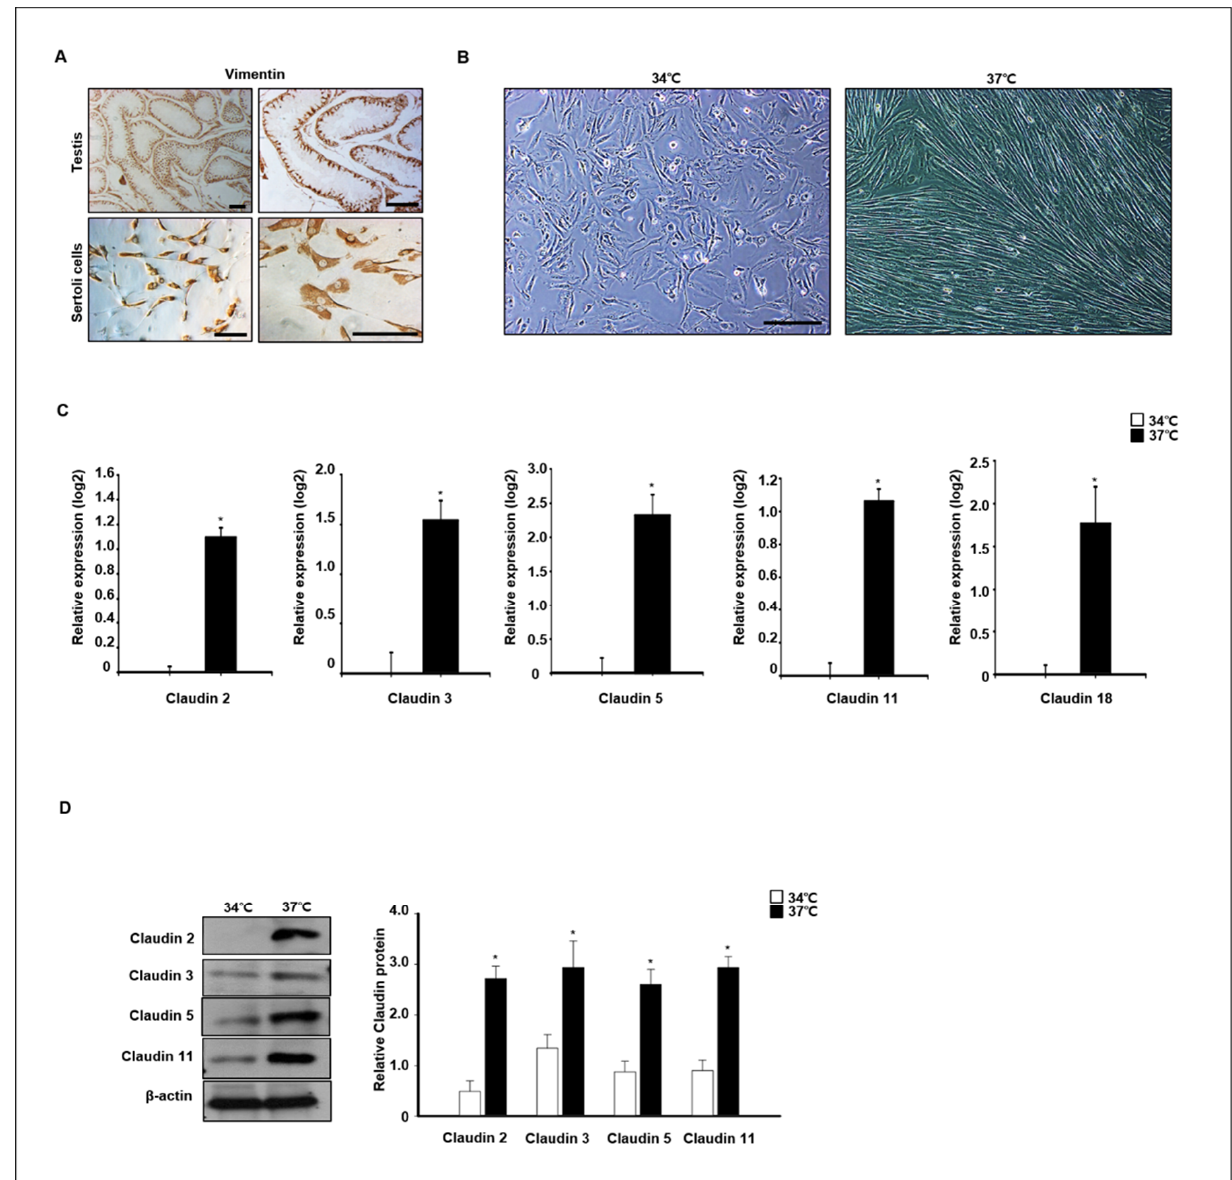
Figure 8. Effect of temperature on claudin expression in in vitro-cultured canine primary Sertoli cells. ( A ) Primary canine Sertoli cells were isolated from 12-month old dog testes. Isolated cells and whole testes were stained with vimentin antibodies as a Sertoli cell marker. ( B ) Images of the morphological change in primary Sertoli cells were taken from cells cultured at 34 and 37 ◦ C. Scale bars = 50 µ m. ( C ) The expression of claudins 2, 3, 5, 11, 18 was determined by qPCR from Sertoli cells cultured at 34 and 37 ◦ C. These genes were detected at higher levels in cells cultured at 37 ◦ C compared to the others. Results are expressed as mean ± standard deviation. * p < 0.05. ( D ) Protein levels of claudins 2, 3, 5, 11, and 18 were detected by immunoblot analysis. Consistently, the levels of these proteins were relatively increased in cells cultured at 37 ◦ C compared to others. Quantitative data are expressed as mean ± standard deviation. * p <